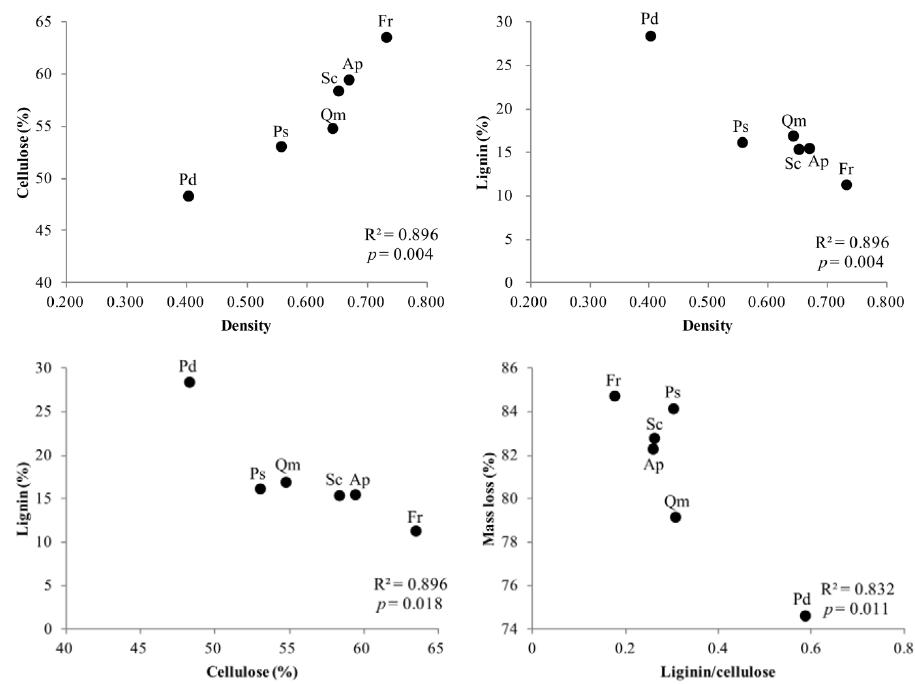
Figure 5. Linear regression between density, cellulose, lignin concentration, and the lignin/cellulose ratio of branch wood disk samples for a decomposition period of 40 months ( n = 5). See abbreviation in Figure